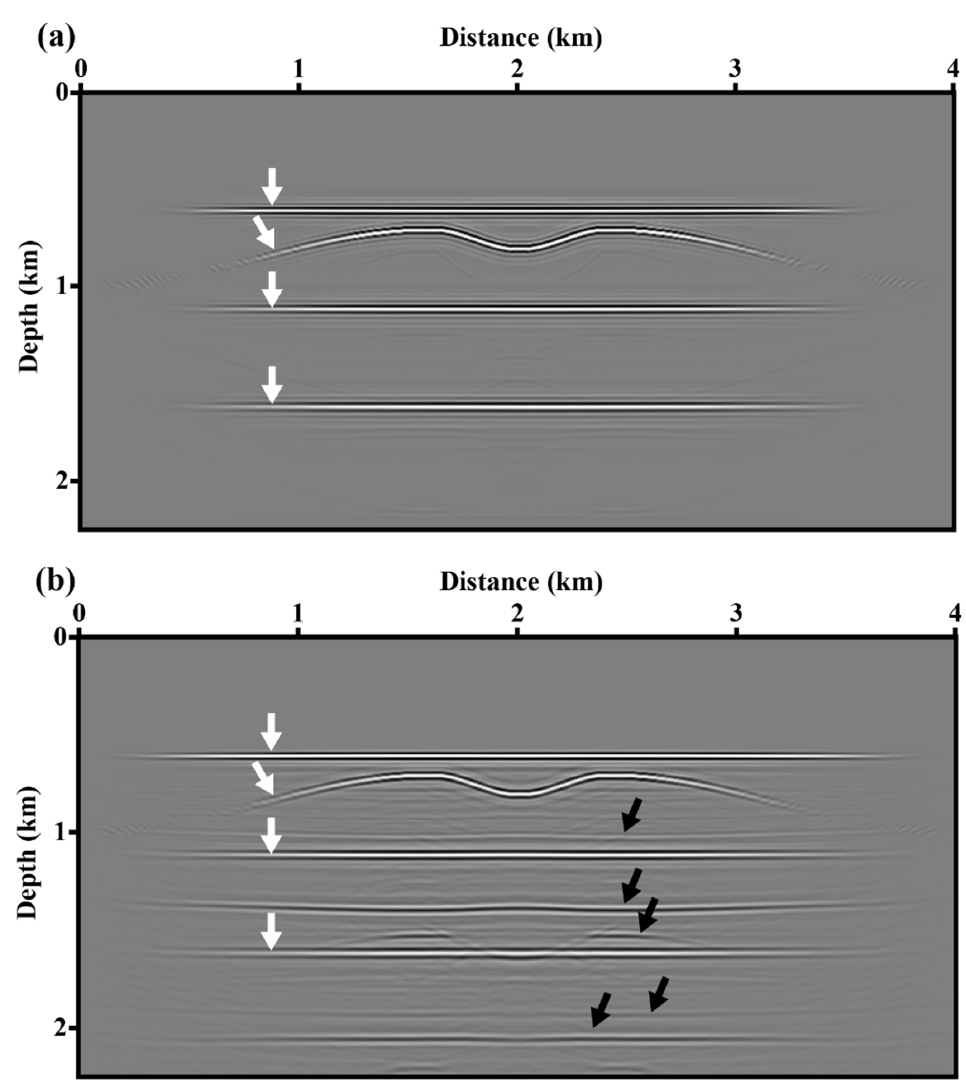
Figure 4. ( a ) The LSRTM image and ( b ) the LSRTMM image. Both images were produced after six iterations. The white arrows in panels a and b illustrate that both LSM algorithms imaged the four interfaces well. As shown by the black arrows in panel b, LSRTMM exhibited a poor capacity to suppress crosstalks generated by undesired multiples crosscorrelations.